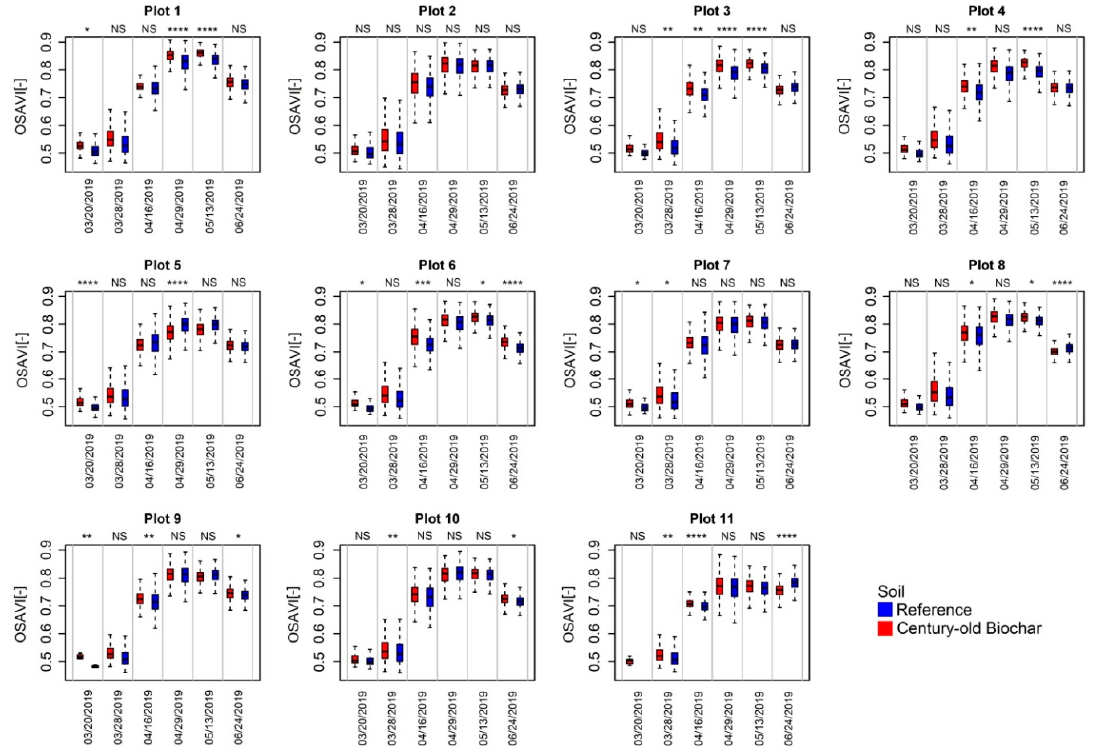
Figure 8. Box plot visualization of optimized soil adjusted vegetation index for the 11 experimental pairs of century-old biochar versus reference plots over the growing season of 2019. The horizontal black line displays the median value, surrounded by box edges representing the 25th and 75th percentiles. Outside of the plot, asterisks *, **, ***, and **** reveal the statistical levels of significance and the acronym NS stands for non-significant. No spectral information is available for reference plot 1 on 20 March because of a flight planning constraint.